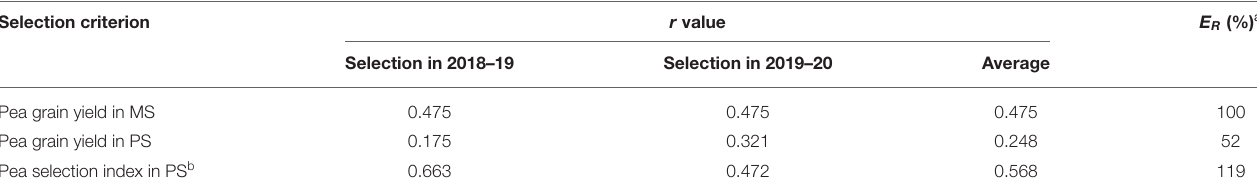
TABLE 6 | Phenotypic correlation ( r ) of pea genotype value in one year (selection year) with pea grain yield in mixed stand with cereals (MS) in another year (target environment) for three selection criteria based on MS or pure stand (PS) selection for individual selection years and averaged across selection years, and average predicted efficiency ( E R ) of selection criteria in PS relative to selection in MS, based on data of 144 pea inbred lines over two cropping